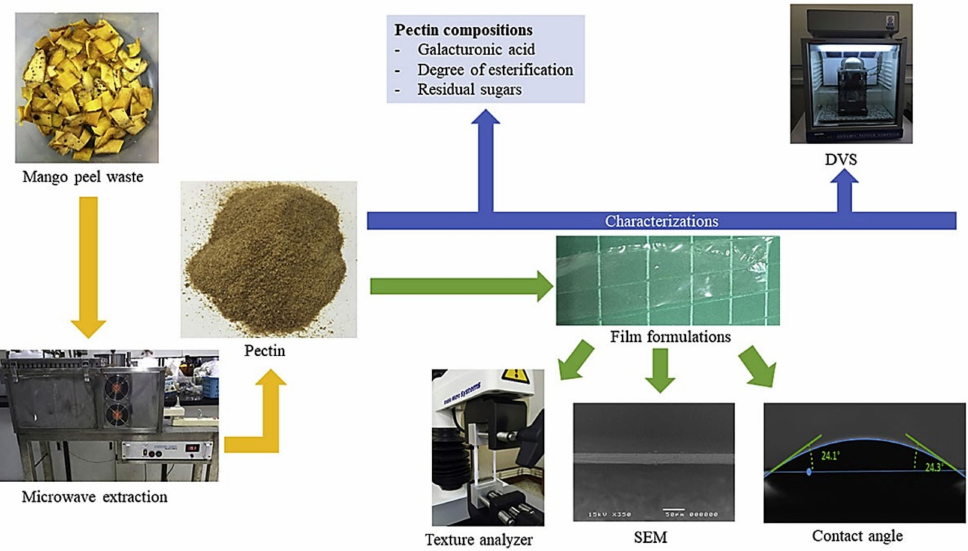
Figure 8. Fabrication of thin polymer films from mango peel waste. Reproduced with permission from Ref. [112]. Copyright 2021